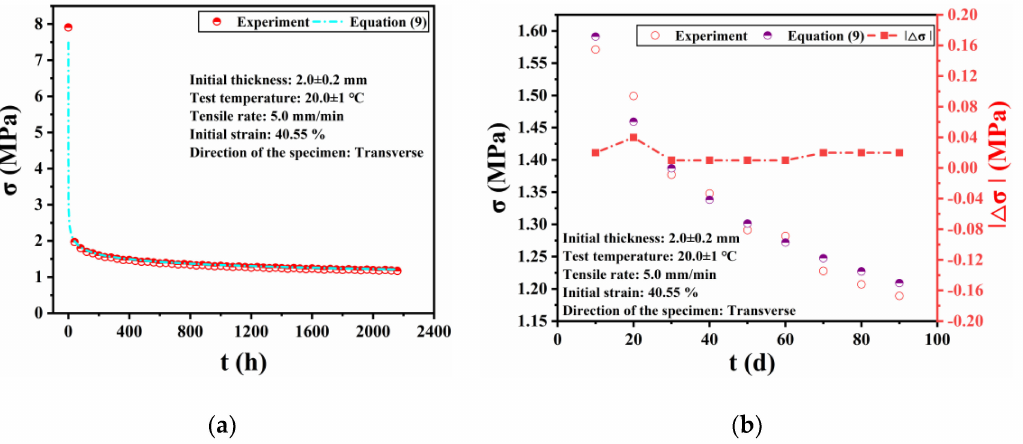
Figure 6. Comparison between the experimental data for 90 d and the calculated results by Equation (9): ( a ) overall trend; ( b ) difference in relaxation stress at specified